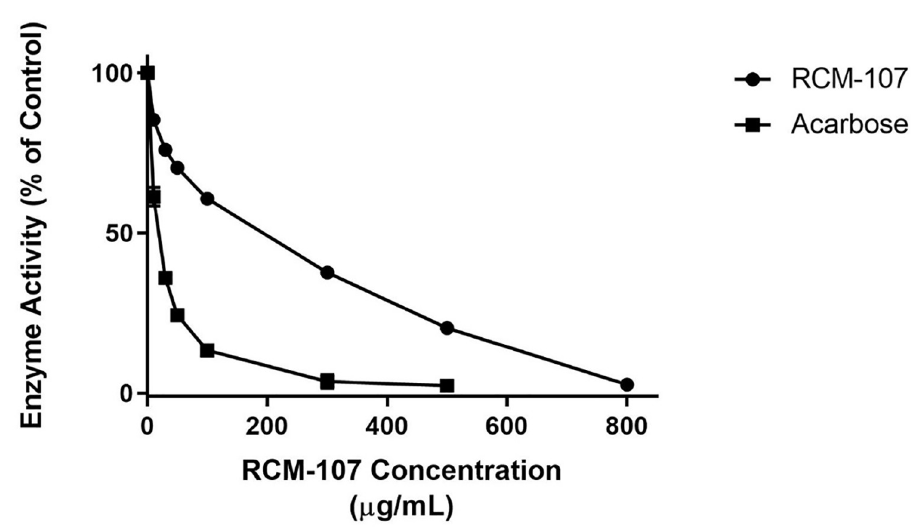
Fig 2. Dose-dependent inhibitory effects of the RCM-107 formula (1–800 μ g mL -1 ) on porcine α -amylase. Data represent mean ± SEM from three independent experiments with three replicates per condition.